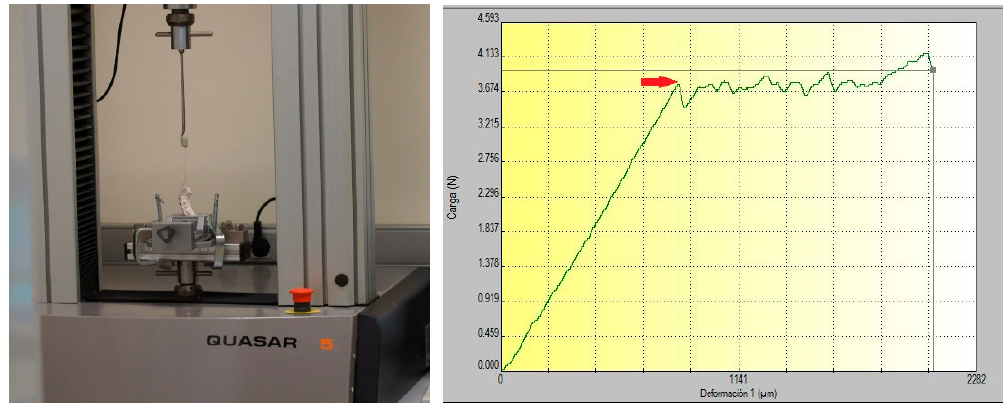
Figure 3. Stereolithographic model with bonded brackets and wire settled on a universal test machine and graph of static friction.